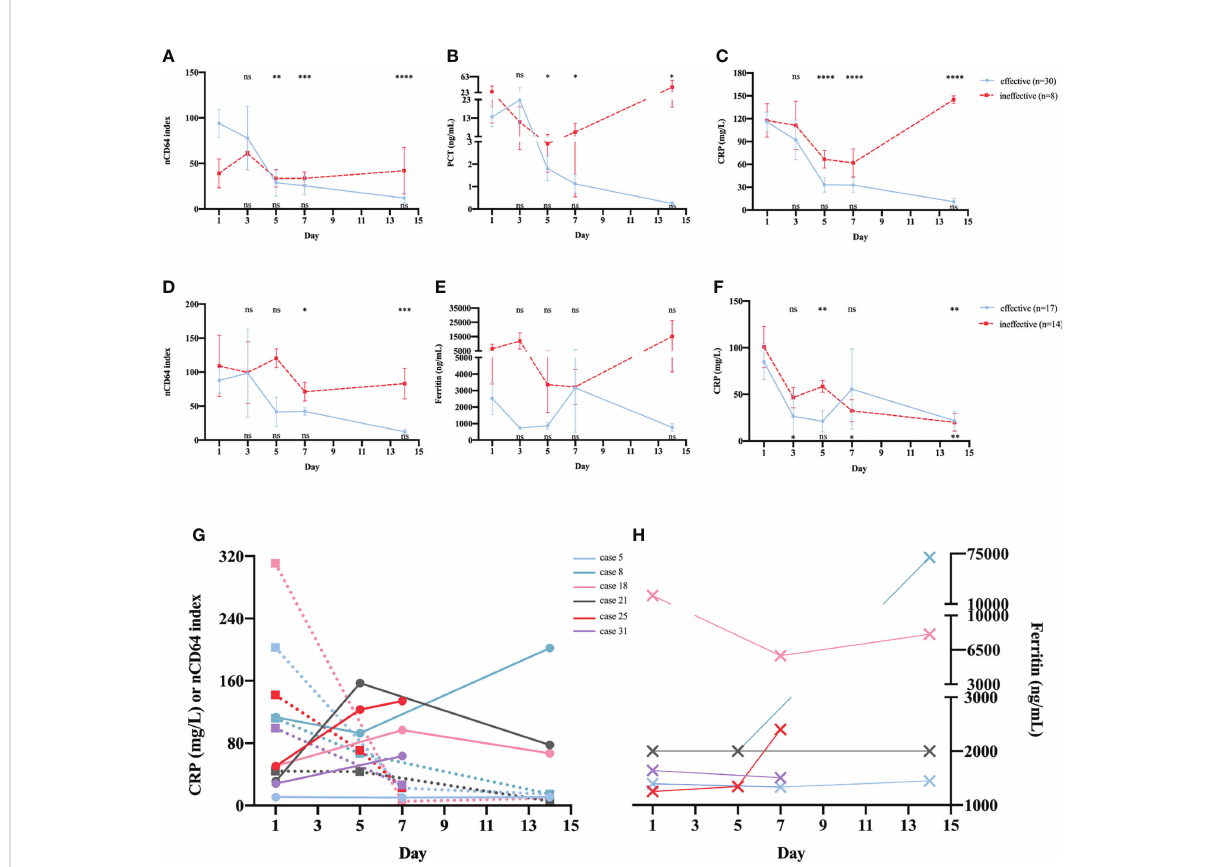
FIGURE 6 Serial determinations of nCD64 index during treatment in patients with sepsis or NIID. Dynamic changes of nCD64 index (A) , PCT (B) , and CRP (C) over time in patients with sepsis. Dynamic changes of nCD64 index (D) , PCT (E) , and CRP (F) over time in patients with NIID. Blue lines represent patients who received effective treatment, and red lines represent patients who received ineffective treatment. The comparisons were performed between follow-up data and baseline data. Data were analyzed using Mann-Whitney U test. The results of statistical analysis in effective and ineffective treatment group were shown at the top and bottom of graph, respectively. (G, H) The trends of nCD64 index, CRP and ferritin over time among six cases in the ineffective treatment NIID group, the dashed lines represent CRP, and the solid lines represent nCD64 index. * P <0.05, ** P <0.01, *** P <0.001, **** P <0.0001. nCD64, neutrophil CD64; CRP, C-reactive protein; NIID, non-infectious in fl ammatory diseases; ns, no signi fi